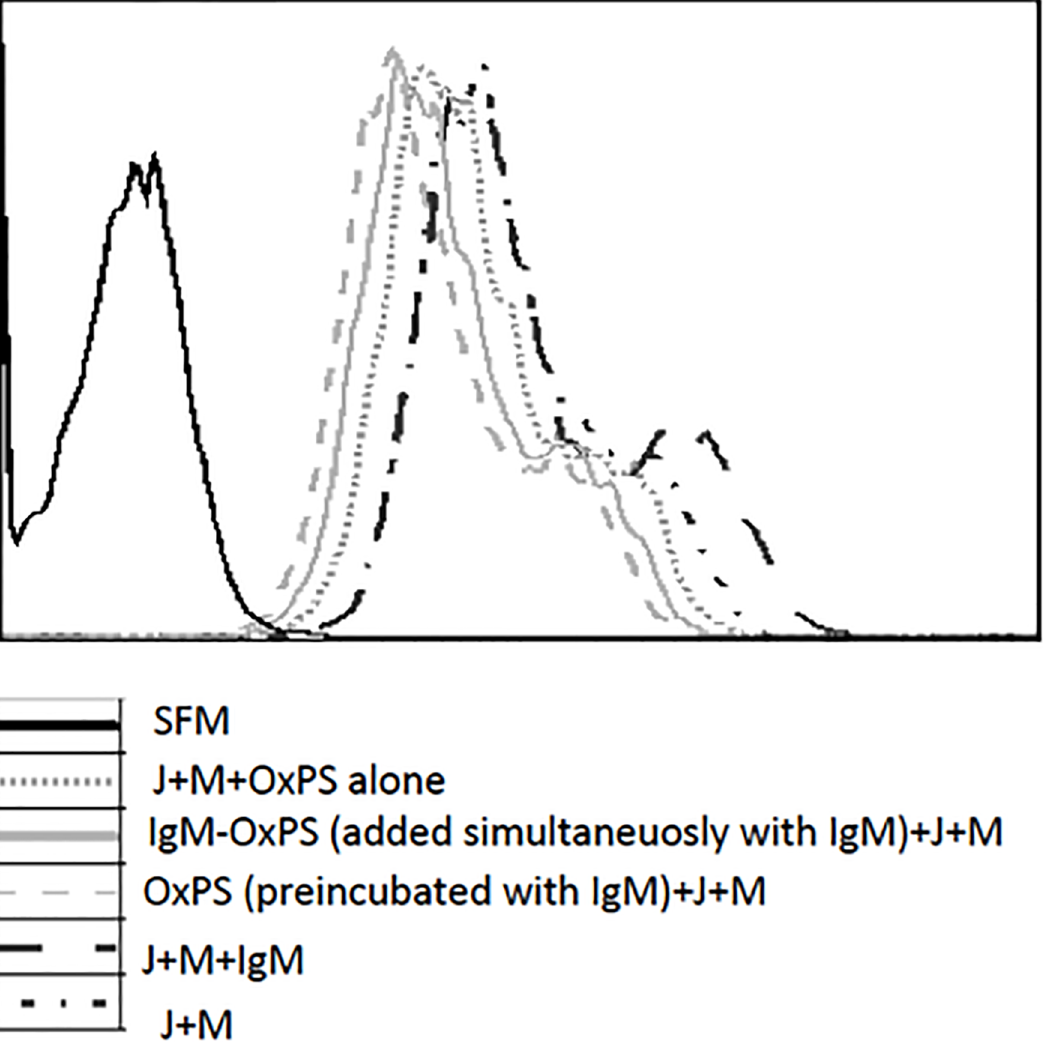
Fig 2. Effect on macrophage-mediated uptake of apoptotic cells. Apoptotic jurkat cells were co-cultured with macrophages 5:1 with or without IgM, IgM which was either preincubated for 90 minutes or simultaneously added in the cell culture system as indicated.Phagocytosis assay was analyzedby flow cytometry. Phagocytosis of apoptoticcells was increasedby total IgM but decreased by oxPS. Preincubation or simultaneous incubation of IgM with OxPS added to the cell culture systems further decreasedthe uptake of apoptotic cells. SFM = serum free medium; J = Jurkat-cells; M = Macrophages; OxPS = oxidizedphosphatidylserine